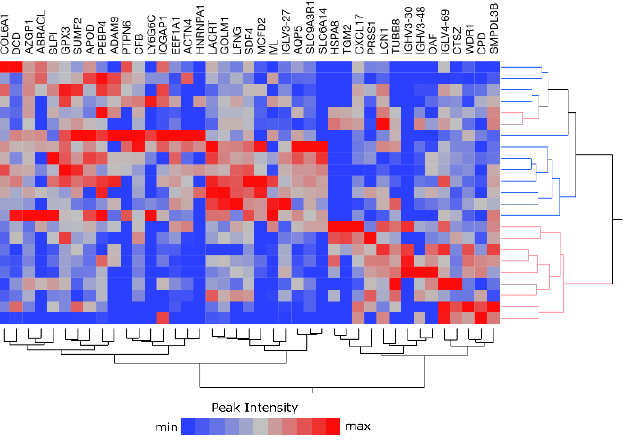
Figure 9. Double-hierarchical clustering analysis of 41 tear proteins selected by linear discriminant analysis (LDA) and 23 samples (pink: F, female; blue: M, male). LFQ by peak intensity is represented by a color code from blue to red, according to increasing abundances.